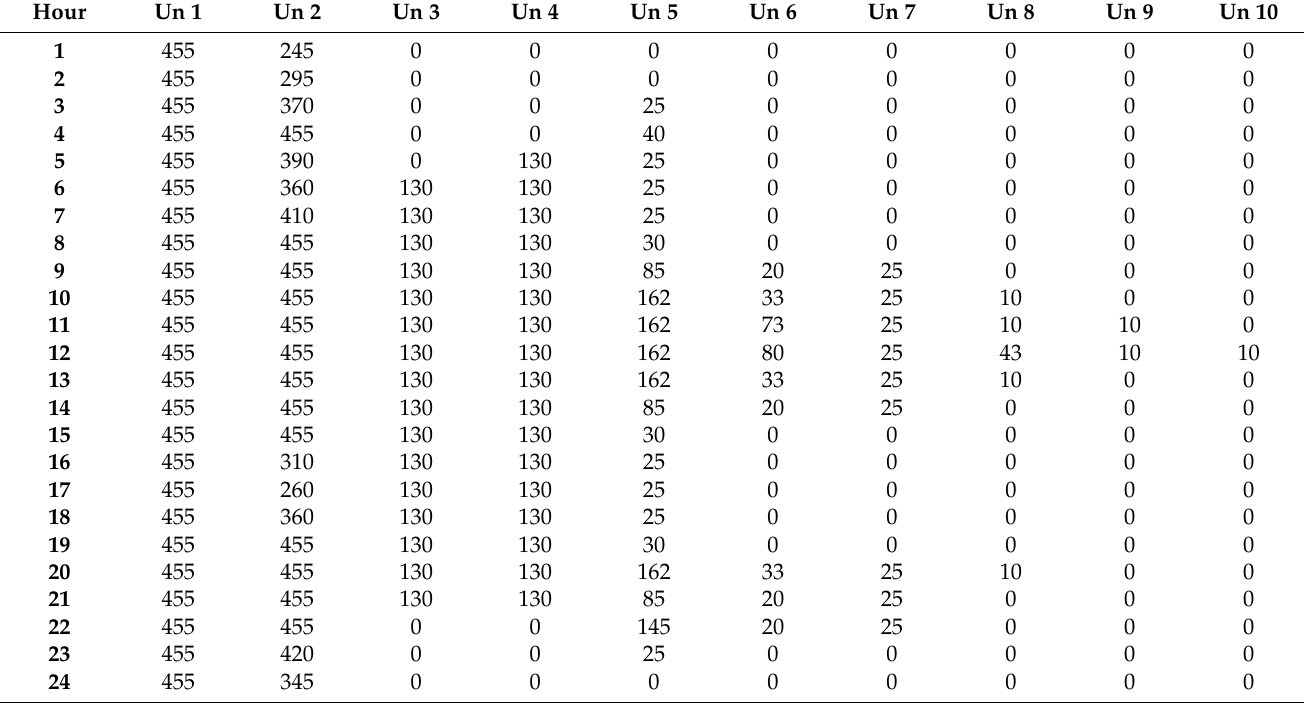
Table 6. Optimal output power for the 10-unit system over 24 h (test system